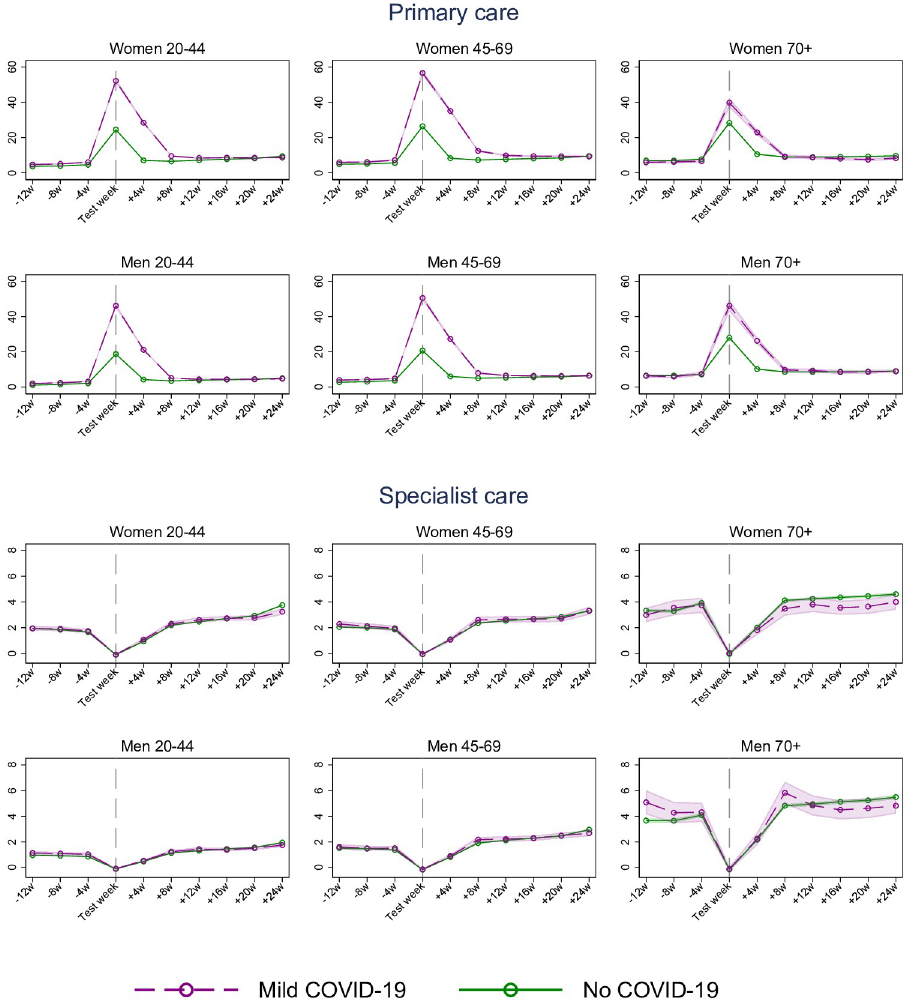
Fig 1. Estimated percent (95% CI) of women and men using primary and specialist (inpatient and outpatient) care in a week, from 3 months before to 6 months after week of PCR test for SARS-CoV-2, for persons with mild COVID-19 and no COVID-19, by age groups. Estimates adjusted for comorbidities, birth country and calendar month. The dip for specialist care around the test week is a mechanical result of the exclusion of persons who were hospitalized with COVID-19 in the test week and the two following